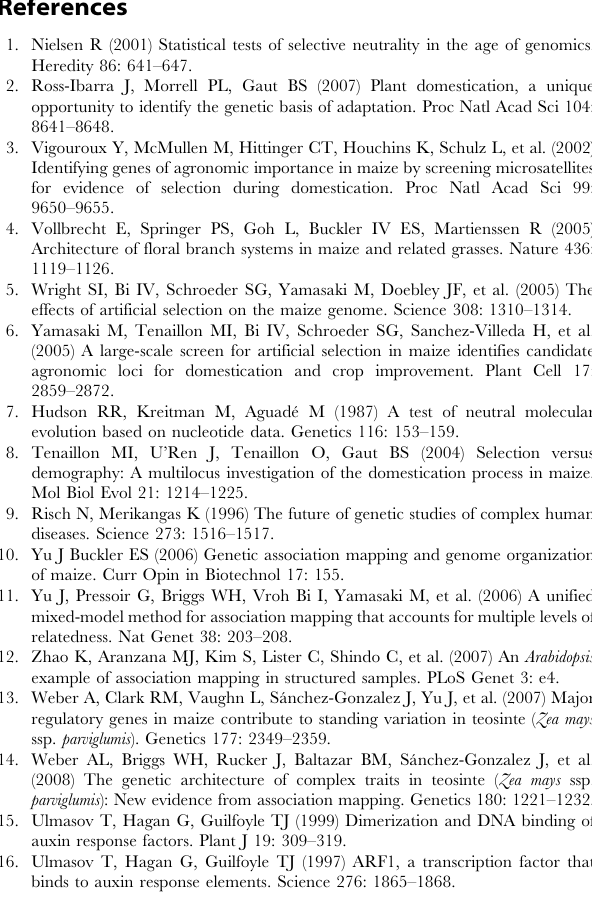
Table S1 List of phenotypes without interesting associations.